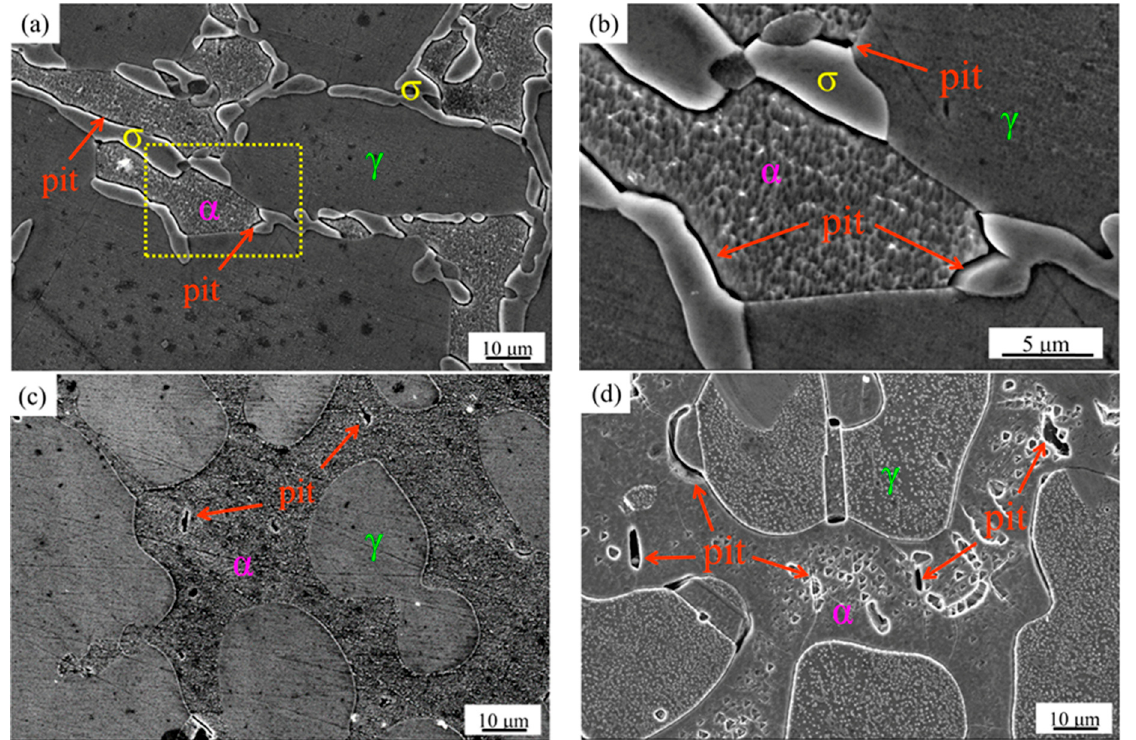
Figure 11. SEM images of the specimens after potentiodynamic anodic polarization test solution treatment at: ( a ) 1040 ◦ C; ( b ) enlarged images of square frame area in ( a ); ( c ) 1100 ◦ C; ( d ) 1200 ◦ C. The pit refers to the area of weak corrosion resistance where the passivation film is damaged by chloride ions and formed by further longitudinal